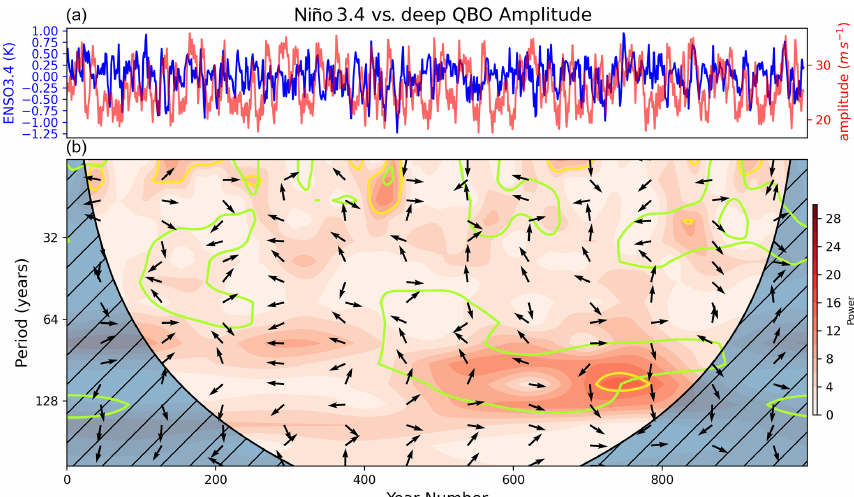
Figure A8. (a) September–November Niño 3.4 index mean (blue) and September–November deep QBO Hilbert amplitude index smoothed with a 5-year window (red). (b) Cross-wavelet power spectrum between the two time series.